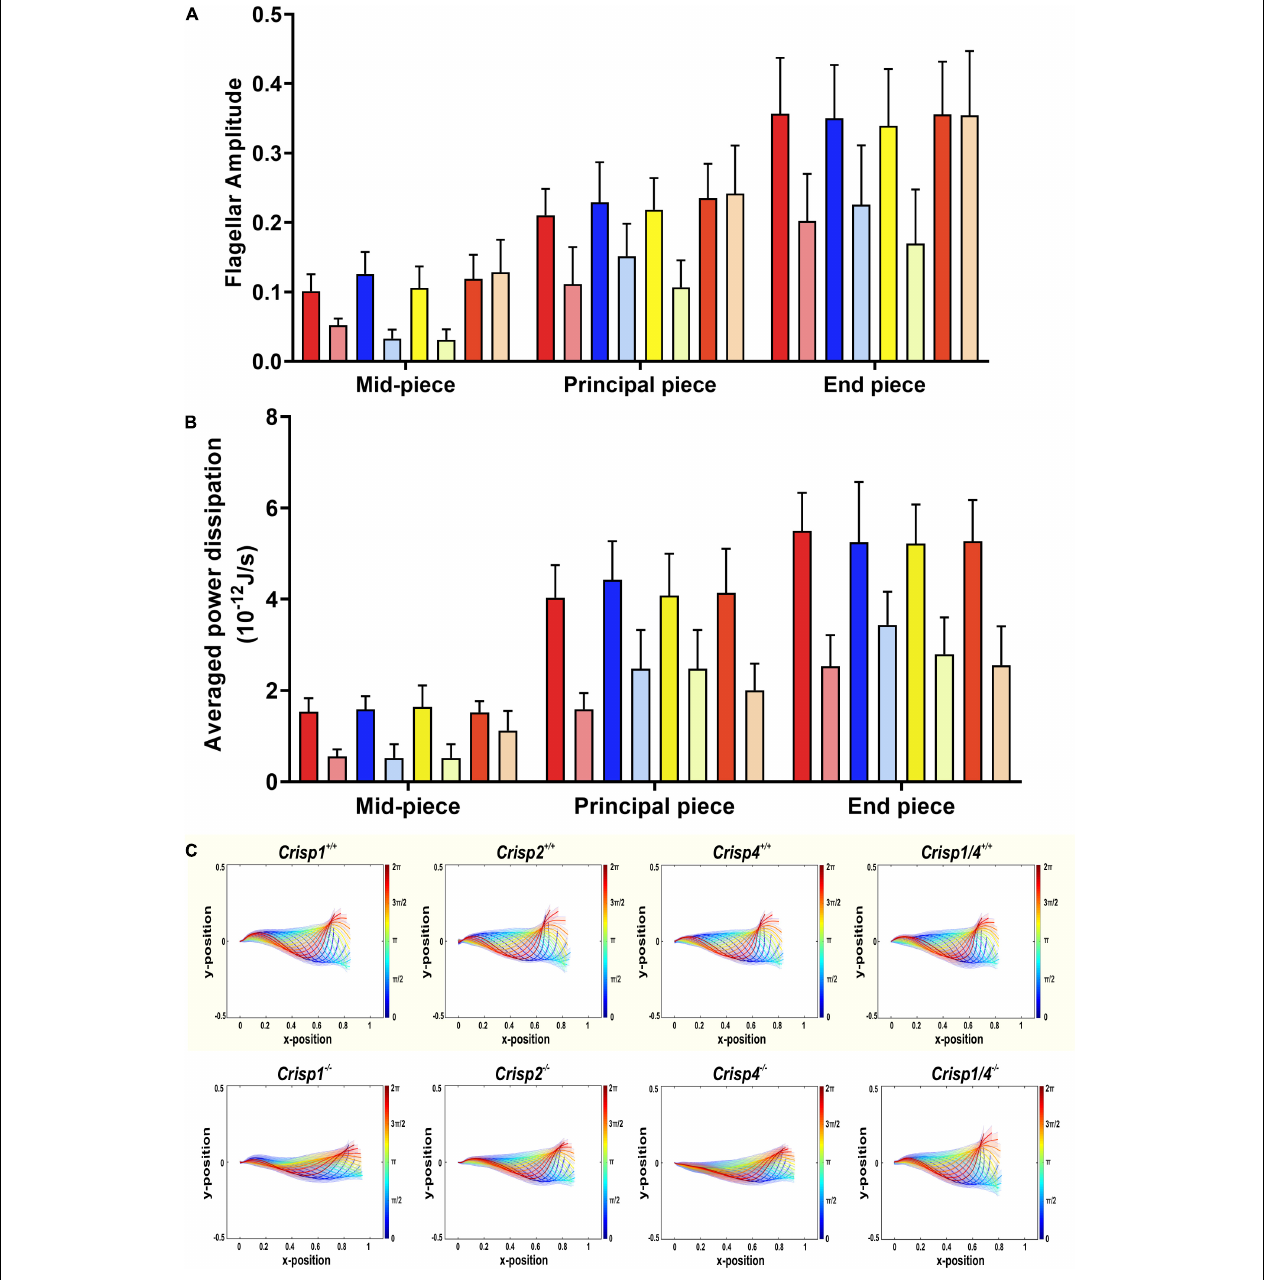
FIGURE 4 | Qualitative and quantitative analysis of the population-averaged flagellar energetics and beat pattern across sperm from Crisp wild type and knock out mice. (A) Analysis of flagellar amplitude along the different regions of flagella starting in the mid-piece (24 µ m), principal piece (80 µ m) and end piece ( ∼ 6 µ m). Differences were analyzed using a two-way ANOVA ( ± SD) on the mean sperm value from individual mice across genotypes. Please refer to Supplementary Tables 3, 3.1 for all the possible interactions between wild type versus knock out genotype. The p values indicate a statistically significant difference between wild type and respective null sperm. The intense color bars represent Crisp wild type mice and lighter version of the same color bars represents Crisp knock out mice, respectively (CRISP1 – red, CRISP2 – blue, CRISP4 – yellow, and CRISP1/4 – orange). (B) Analysis of power dissipation (10 − 12 J/s) per beat cycle along the different regions of the flagella – mid-piece, principal piece and end piece across wild type and knock out mice. Data presented is from a total number of 25–30 sperm/genotype. N = 5–6 mice/genotype. Data was analyzed by two-way ANOVA ( ± SD) on the mean sperm value from individual mouse genotypes. Comparisons were between sperm from wild type and knockout mice of each mouse strain, rather than between strains. The intense color bars represent Crisp wild type mice data and lighter version of the same color bars represents Crisp knock out mice data, respectively (CRISP1 – red, CRISP2 – blue, CRISP4 – yellow, and CRISP1/4 – orange). See Supplementary Table 4 for all the possible interactions between wild type versus knock out genotype. (C) Reconstruction of genotypic mean beat cycle of the sperm across four Crisp wild type (top panel) and Crisp knock out genotypes. The mean beat cycle of individual genotypes was constructed by analyzing 25–30 sperm/genotype. The color spectrum represents the non-dimensional time